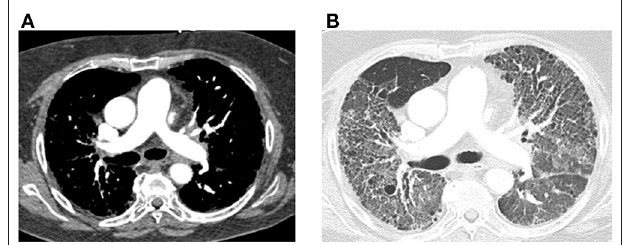
FIGURE 2 | Computed tomography (CT) images of the chest with and without contrast are shown from a 64-year-old female with connective tissue disease, severe interstitial lung disease, and mixed severe pulmonary hypertension are shown. (A) Transaxial images are shown demonstrating an enlarged main pulmonary arterial size at 3.2cm when compared to ascending aorta size of 2.9cm at the same level suggestive of pulmonary hypertension. There is no evidence of pulmonary embolism with optimal contrast opacification. (B) Transaxial images in the lung window demonstrate extensive bilateral diffuse groundglass opacities and honeycombing. There is associated intralobular and interstitial thickening and bronchiectasis consistent with patient’s known history of connective tissue disease associated non-specific interstitial pneumonitis.